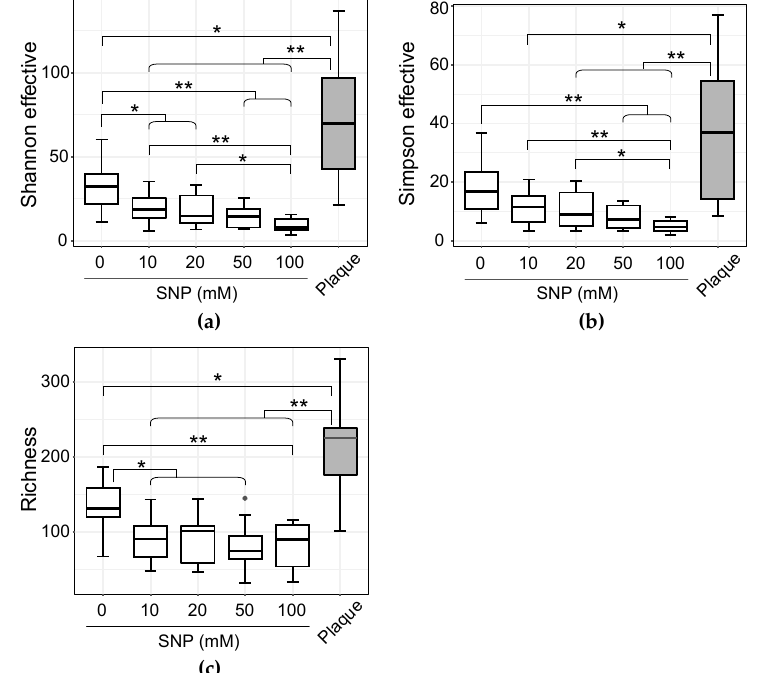
Figure 3. Alpha diversity indices in dental plaque and cultured samples. The R-based Rhea pipeline [41] was used for data analysis. The indices are plotted with three alpha diversity indicators: ( a ) Shannon effective; ( b ) Simpson effective; ( c ) species richness. p -values determined by paired Wilcoxon signed rank-sum test (* p < 0.05, ** p < 0.01).